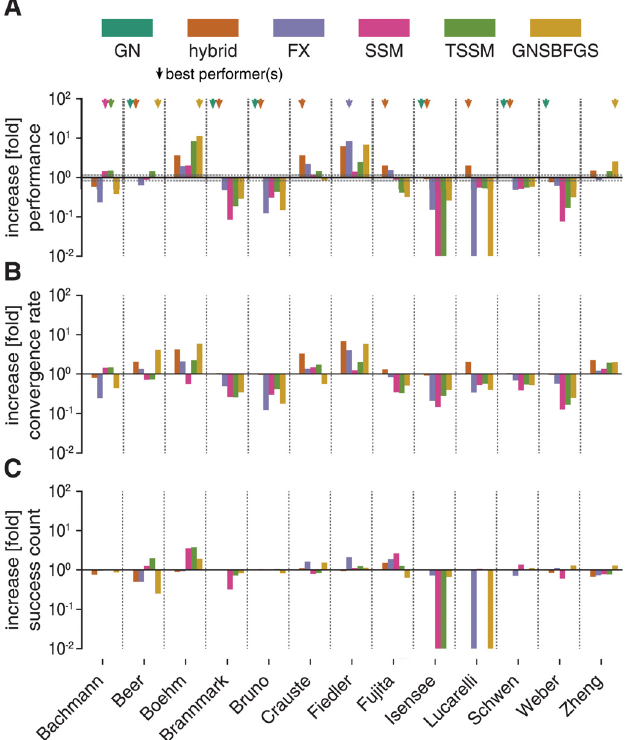
Fig 6. Evaluation of hybrid switching approximation. Color scheme is the same in all panels. All increases/decreases are relative to fides 2D/GN . A : Performance comparison ( ϕ ). B : Increase in convergence count γ . C : Increase in convergence rate ν